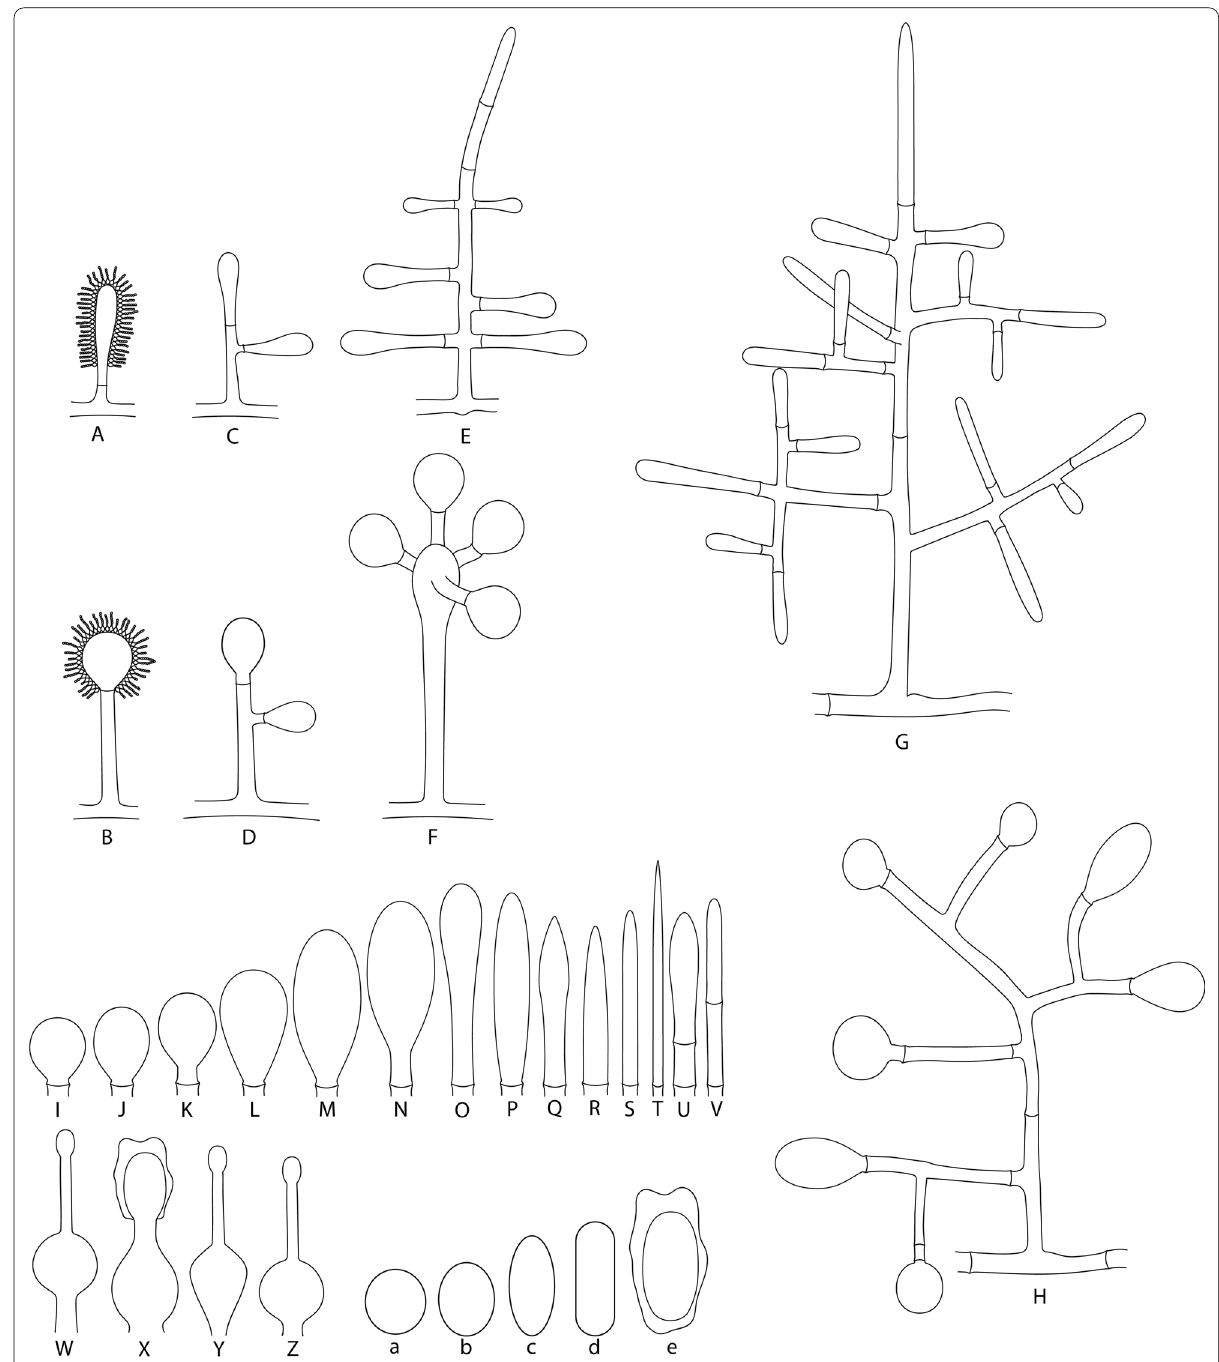
Fig. 4 Illustration of microscopic structures of the genus Escovopsis . A , B Mono-vesiculate conidiophores. C – H Poly-vesiculate conidiophores. F: Conidiophore with “swollen cell”. I – V Different shapes of vesicles ( I : Globose, J : Subglobose, K : Capitate, L : Obovoid, M : Prolate, N : Spatulate, O : Clavate, P : Cymbiform, Q : Lanceolate, R : Subulate, S : Cylindric, T : Filiform, U : Clavate-septate, V : Cylindric-septate; only vesicles without phialides are illustrated). W – Z : Different shapes of the phialides. a–e: Different shapes of conidia (a: Globose, b: Subglobose, c: Ellipsoidal, d: Oblong,